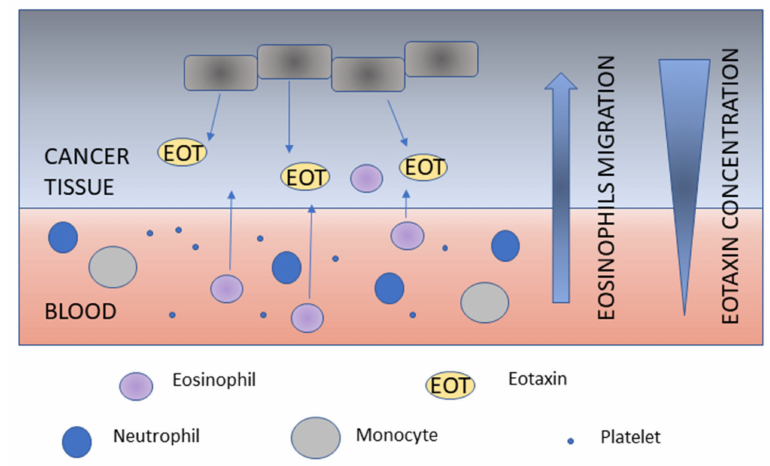
Figure 2. Eotaxins and eosinophils migration.